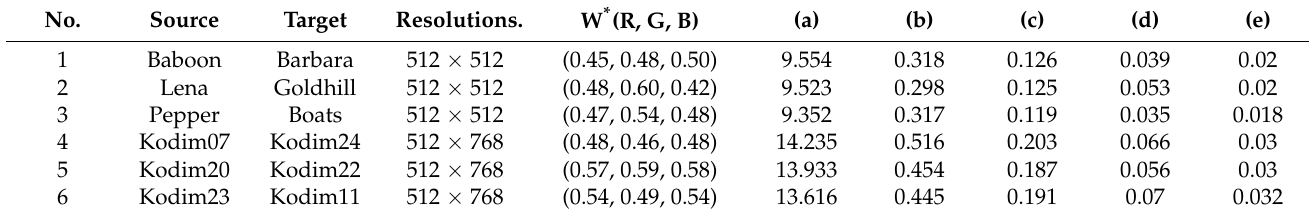
Table 8. The timing results of six test images.